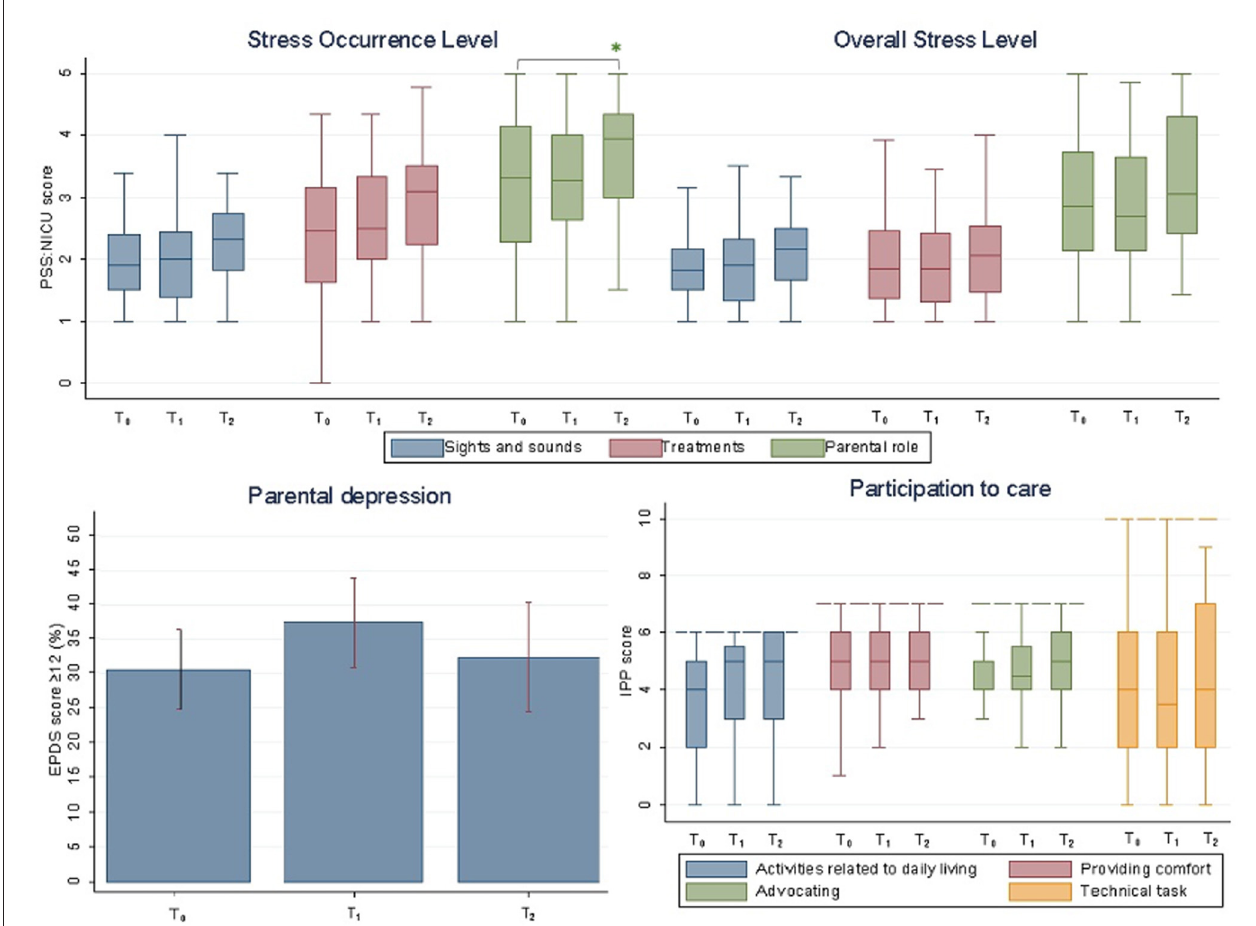
FIGURE 1 | Stress (PSS:NICU), depression (EPDS), and participation in care (IPP) during three COVID-19 pandemic periods. PSS:NICU (Stress Occurrence Level and Overall Stress Level) and IPP scores are presented as medians. EPDS ≥ 12 is presented as percentage and standard deviation. Maximum scores vary for each IPP subdomain and are graphically shown with a dashed line. *statistically significance; T 0 , pre-pandemic; T 1 , low COVID-19 incidence; T 2 , high COVID-19 incidence. PSS:NICU, Parenteral Stressor Scale in the NICU; EPDS, the Edinburgh Postnatal Depression Scale; IPP, Index of Parental